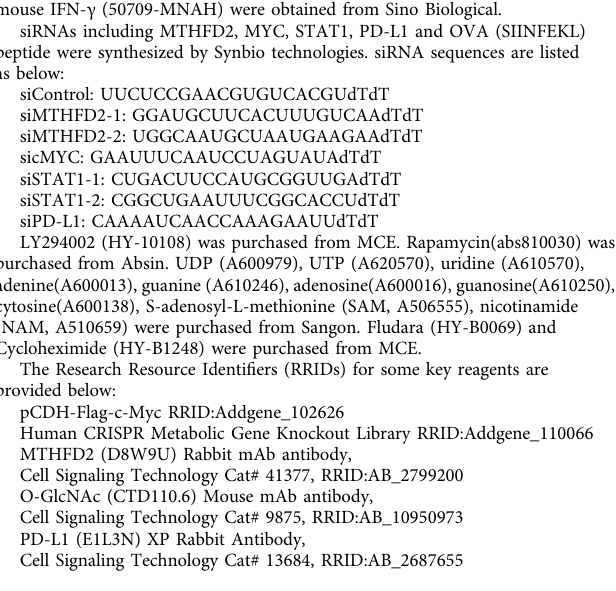
Fig. 5 Protein O-GlcNAcylation mediates MTHFD2 and uridine-related-metabolites enhanced PD-L1 transcription. a The Uridine-related metabolites analysis in SW1990 cells with siMTHFD2 (upper). Diagram for protein O-GlcNAcylation modulated by metabolites in the hexosamine biosynthetic pathway (lower). b SW1990 cells with siMTHFD2 were treated with 0.3 mM UDP or 0.6 mM UTP for 24 h, and immunoblotting analyses were performed using the indicated antibodies. c – e SW1990 cells with siMTHFD2 were expressed with Myc-OGT, and immunoblotting analyses were performed using the indicated antibodies ( c ), PD-L1 mRNA levels were analyzed by real-time PCR ( d ) ( n = 3 independent experiments) and the transcriptional activity of PD-L1 promoter (from 000 bp to 0 bp) was examined by a luciferase-based reporter assay ( e ) ( n = 6 independent experiments). f SW1990 cells transfected with indicated expressing vectors, immunoblotting analyses were performed using the indicated antibodies. g SW1990 cells transfected with indicated siRNAs and expressing vectors, were incubated with activated human CD8 + effector T cells for 16 h and the cytotoxicity was measured by LDH release assay ( n = 4 independent experiments). h Immunohistochemical staining with indicated antibodies was performed on 73 consecutive human pancreas tumor specimens. Representative images are shown. Scale bars: 100 μ m. i Semi-quantitative scoring between MTHFD2 and O-GlcNAc were performed (Pearson ’ s correlation test; R = 0.6986, P < 0.001.). j Semi-quantitative scoring between O-GlcNAc and PD-L1 were performed (Pearson ’ s correlation test; R = 0.6697, P < 0.001.). In ( d , e , and g ), the values are presented as mean ± s.e.m.; p values (Student ’ s t test, two-sided) with control or the indicated groups are presented (also see Supplementary Fig.